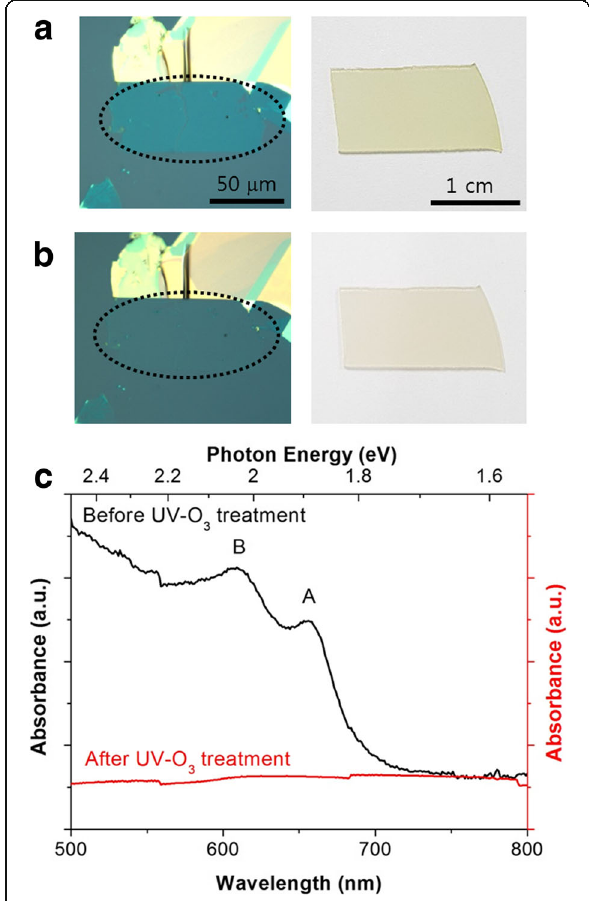
Fig. 2 Mechanically exfoliated flakes and CVD thin films of MoS 2 monolayers a before and b after 5-min UV-O 3 treatment (dotted Fig. 3 PL spectra of MoS 2 monolayers a mechanically exfoliated flakes on SiO 2 /Si substrates and b CVD thin films on sapphire substrates after UV-O 3 treatment for 0, 1, 3, and 5